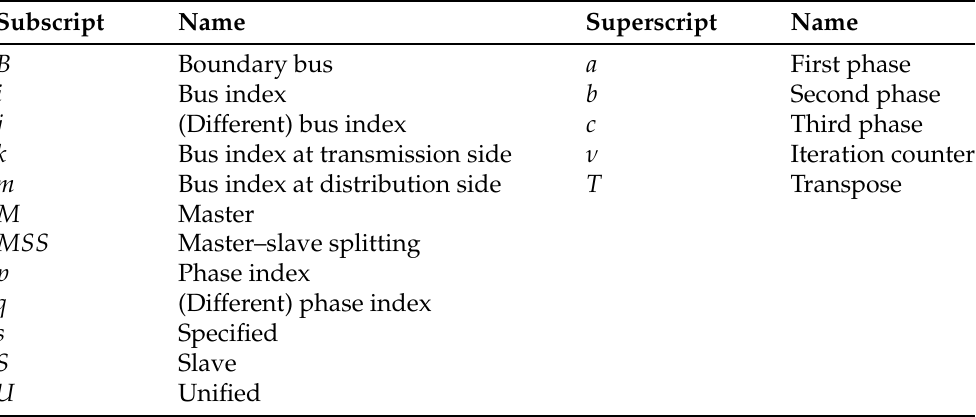
Table A2. List of subscripts and superscripts used in this work, including their